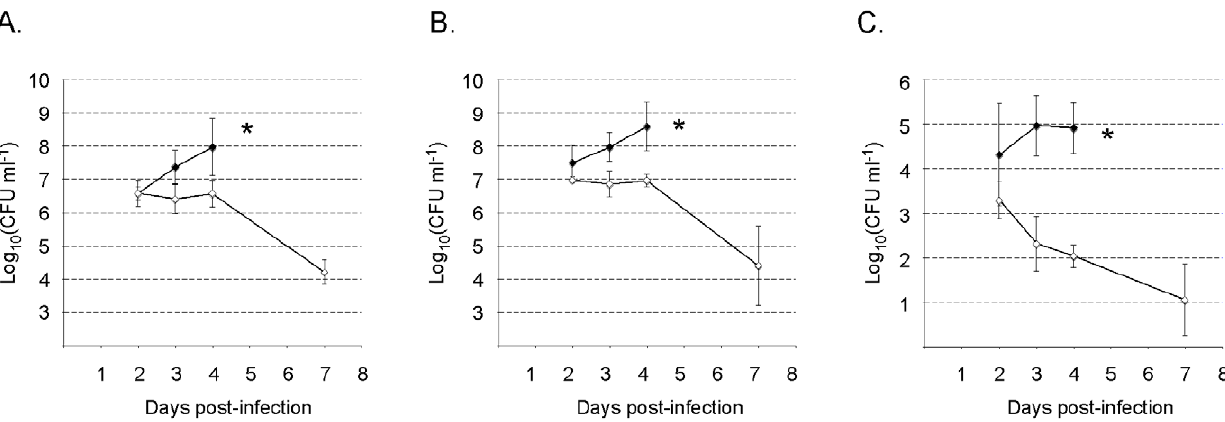
Figure 8. In vivo dissemination of LVS and trkH. BALB/c mice were infected with approximately 10 4 LVS or trkH bacteria by the i.p. route. After 2, 3, 4, and 7 days of infection, groups of five mice were sacrificed and the bacterial burden in the spleen, liver, and blood was determined by plating tissue homogenates on chocolate agar. *: all mice infected by LVS died before day 7.